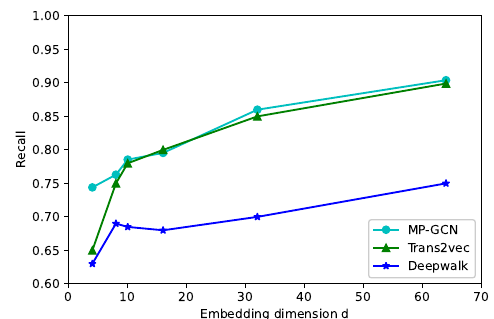
Figure 5. Precision of the classification.